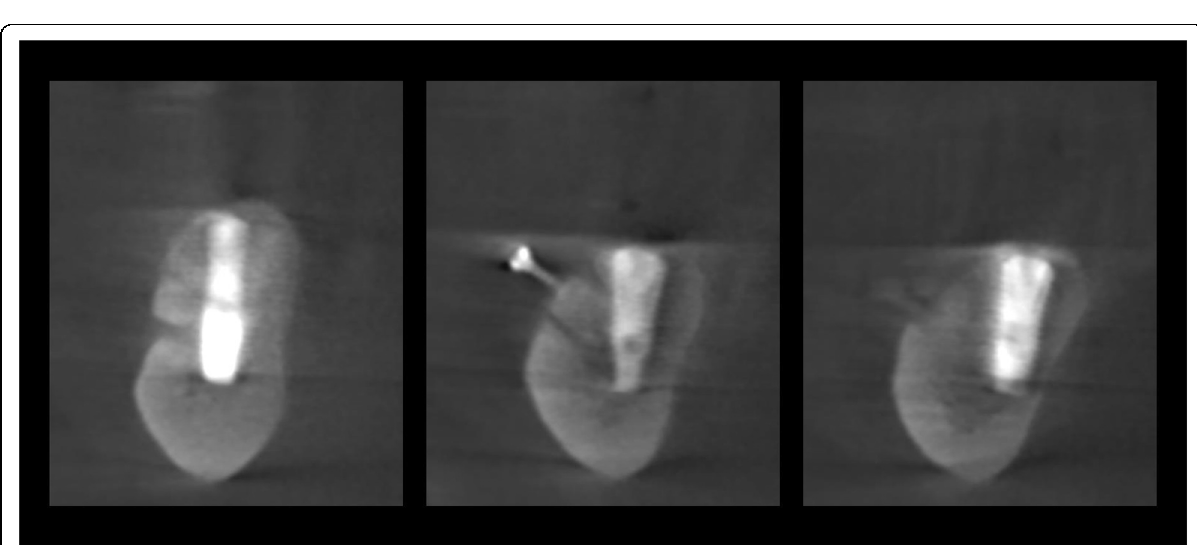
Fig. 7 A CT scan after surgery